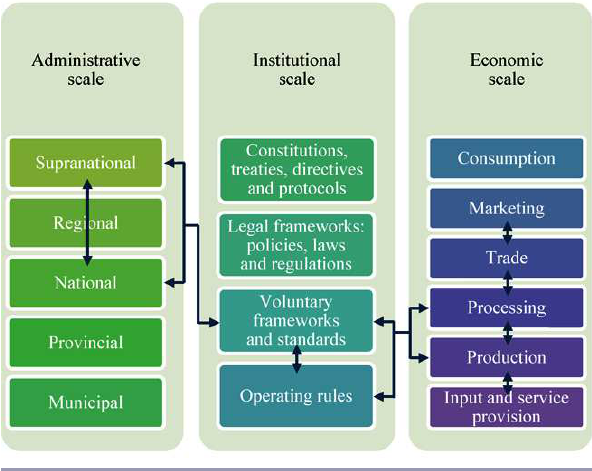
Fig. 6. . Schematic representation of scale dynamics analysis: Step 4, Phase